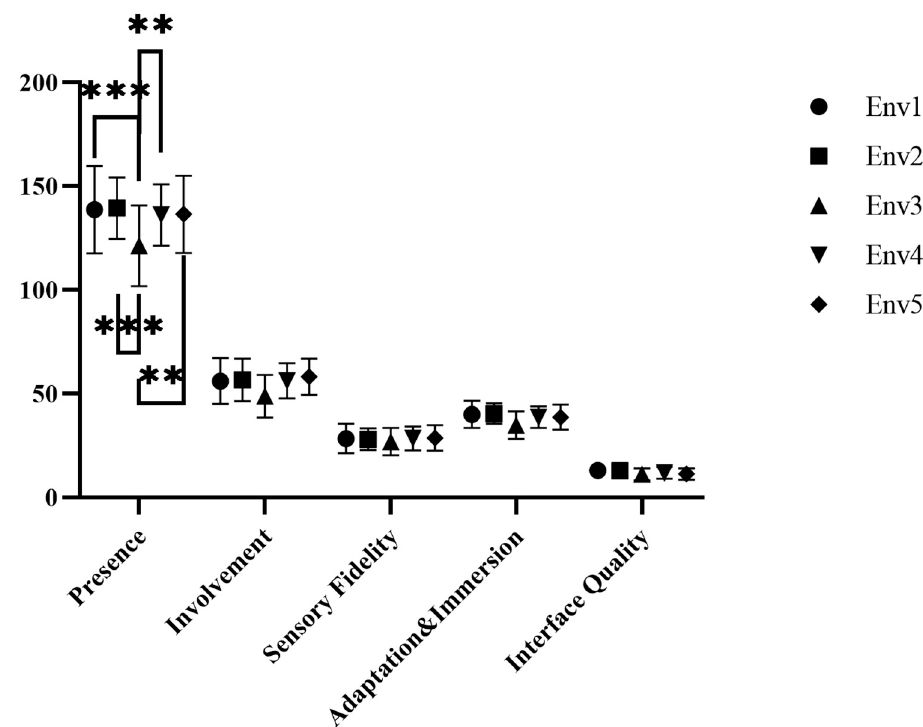
Figure 14. The total score of presence and each dimension score. Interpretation: ** p < 0.01, and *** p < 0.001. Env1, VR urban environment visual experiencing group; Env2, VR restorative environment visual experiencing group; Env3, VR restorative environment interactive experiencing group; Env4, VR restorative environment with fishing interaction group; Env5, VR restorative environment with watering interaction group.